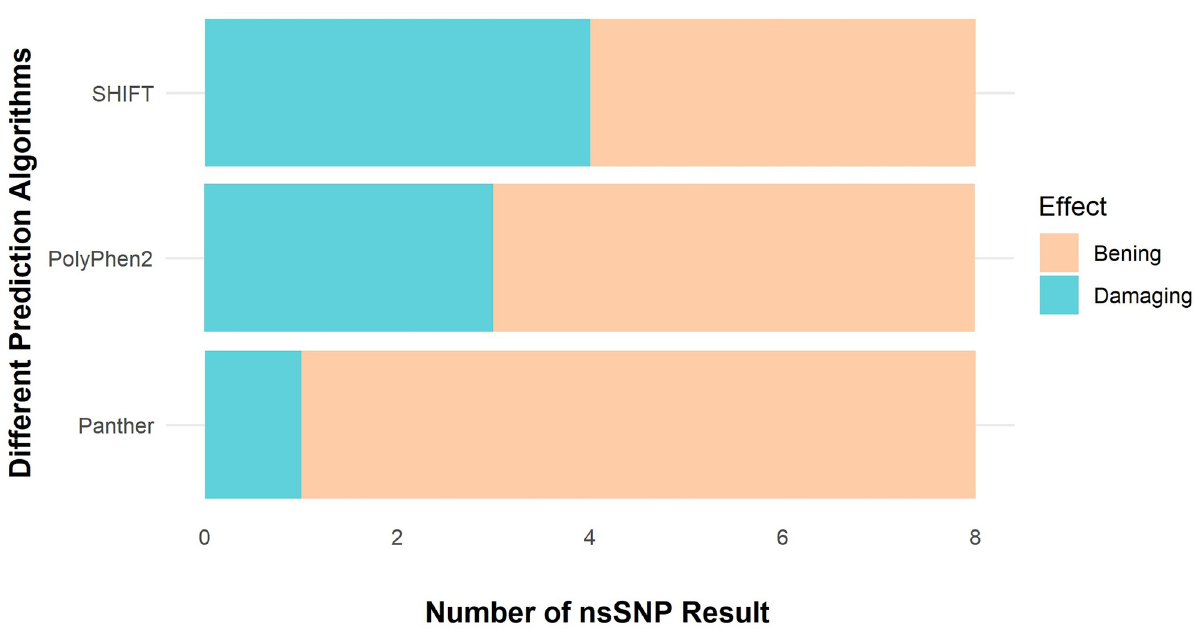
Fig 6. Different database data